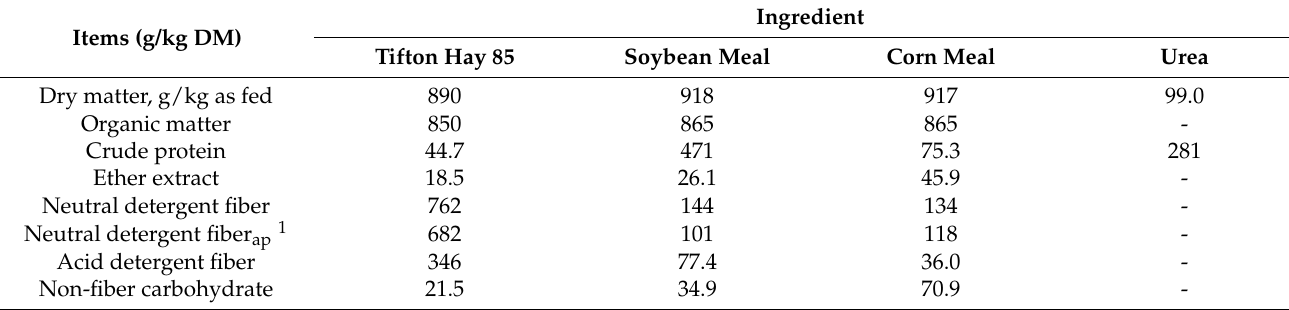
Table 1. Chemical composition of feed